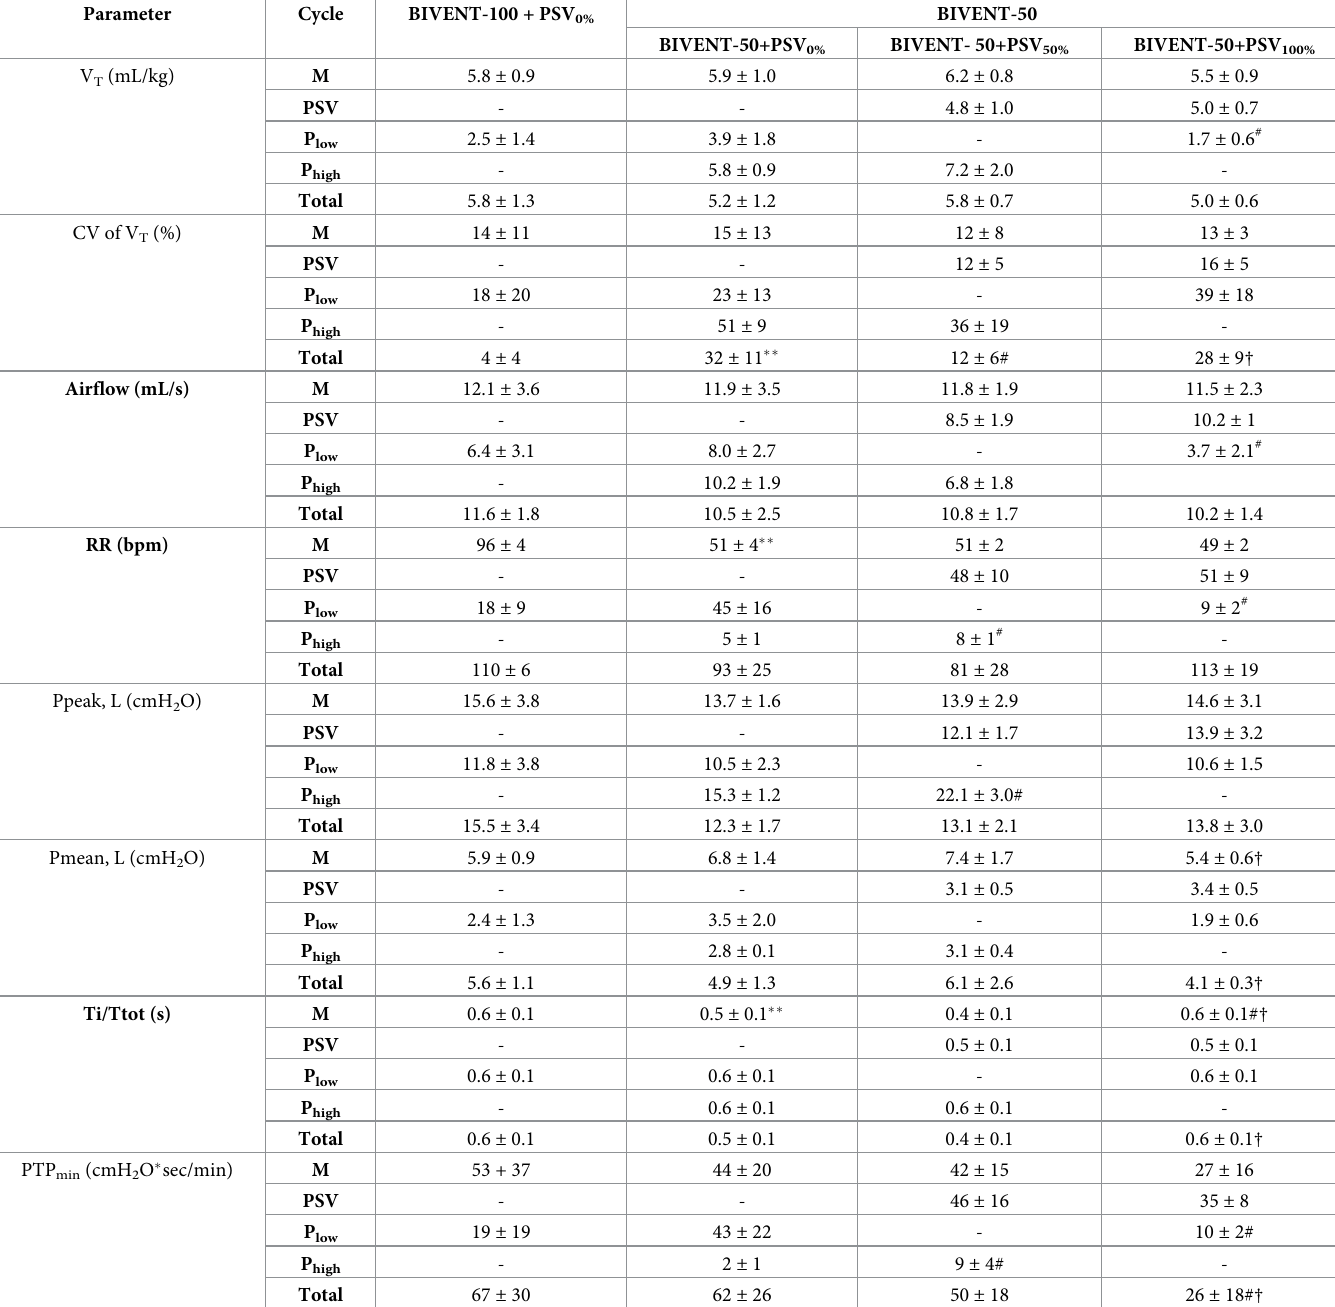
Table 1. Respiratory mechanical parameters at timepoint